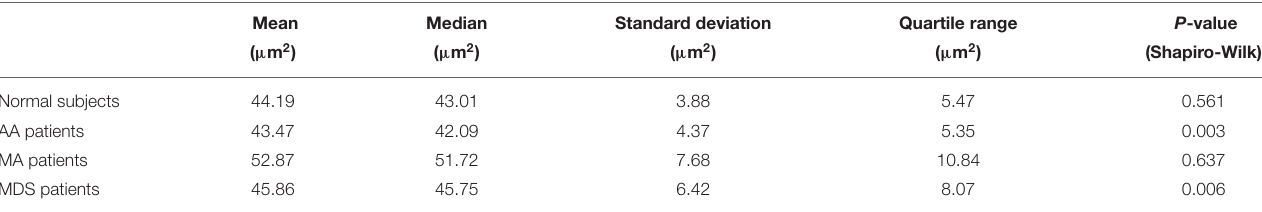
TABLE 2 | The results of area in normal subjects and patients with AA, MA, and